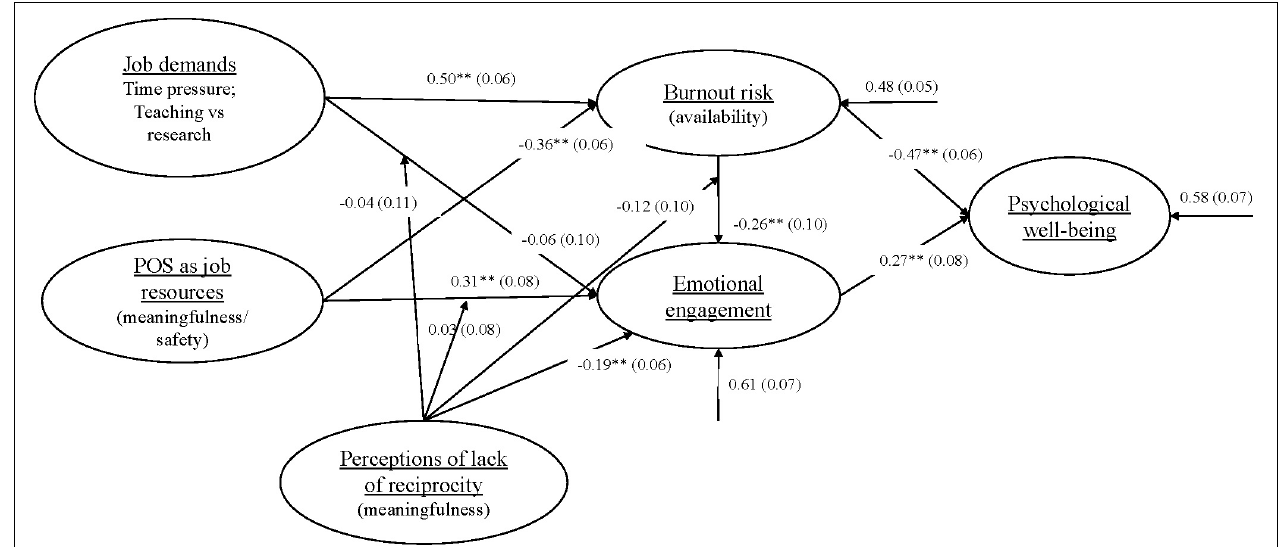
FIGURE 2 | The path/structural model tested Note. ** p <